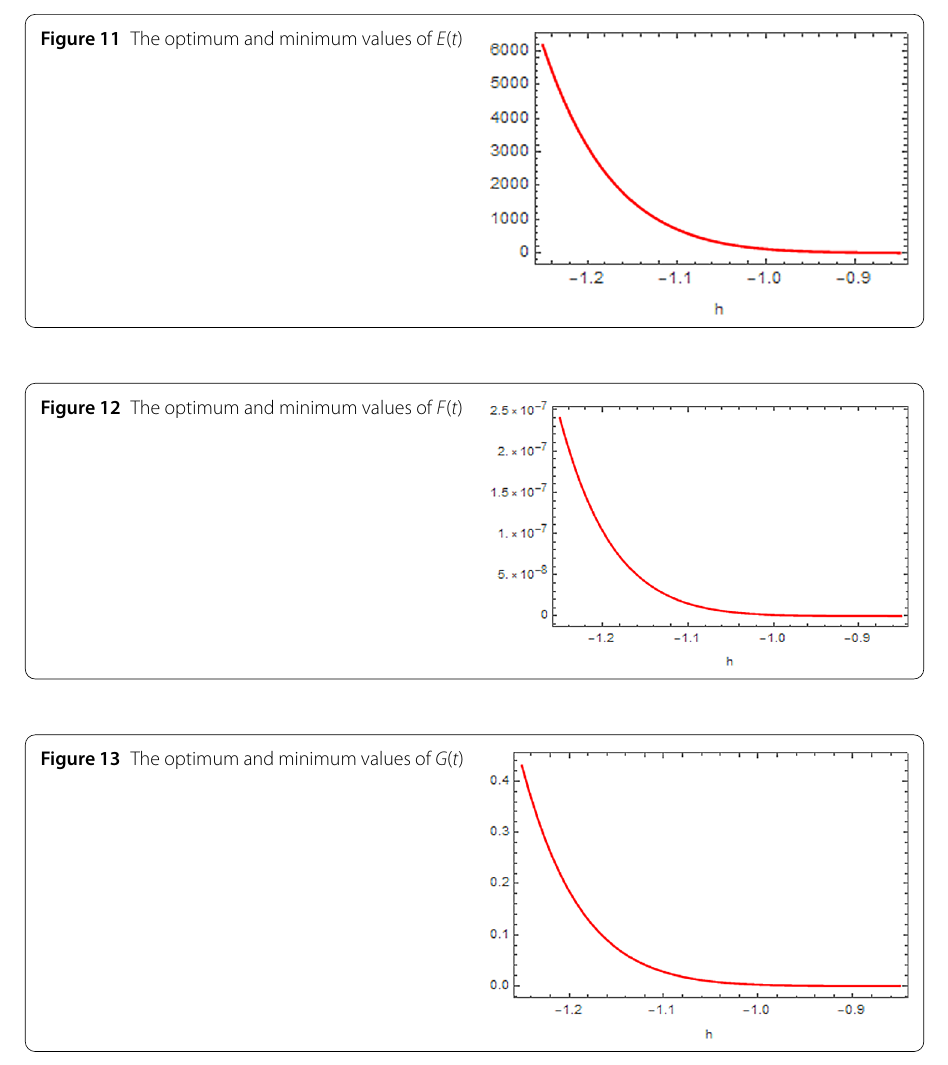
Figure 11 The optimum and minimum values of E ( t )